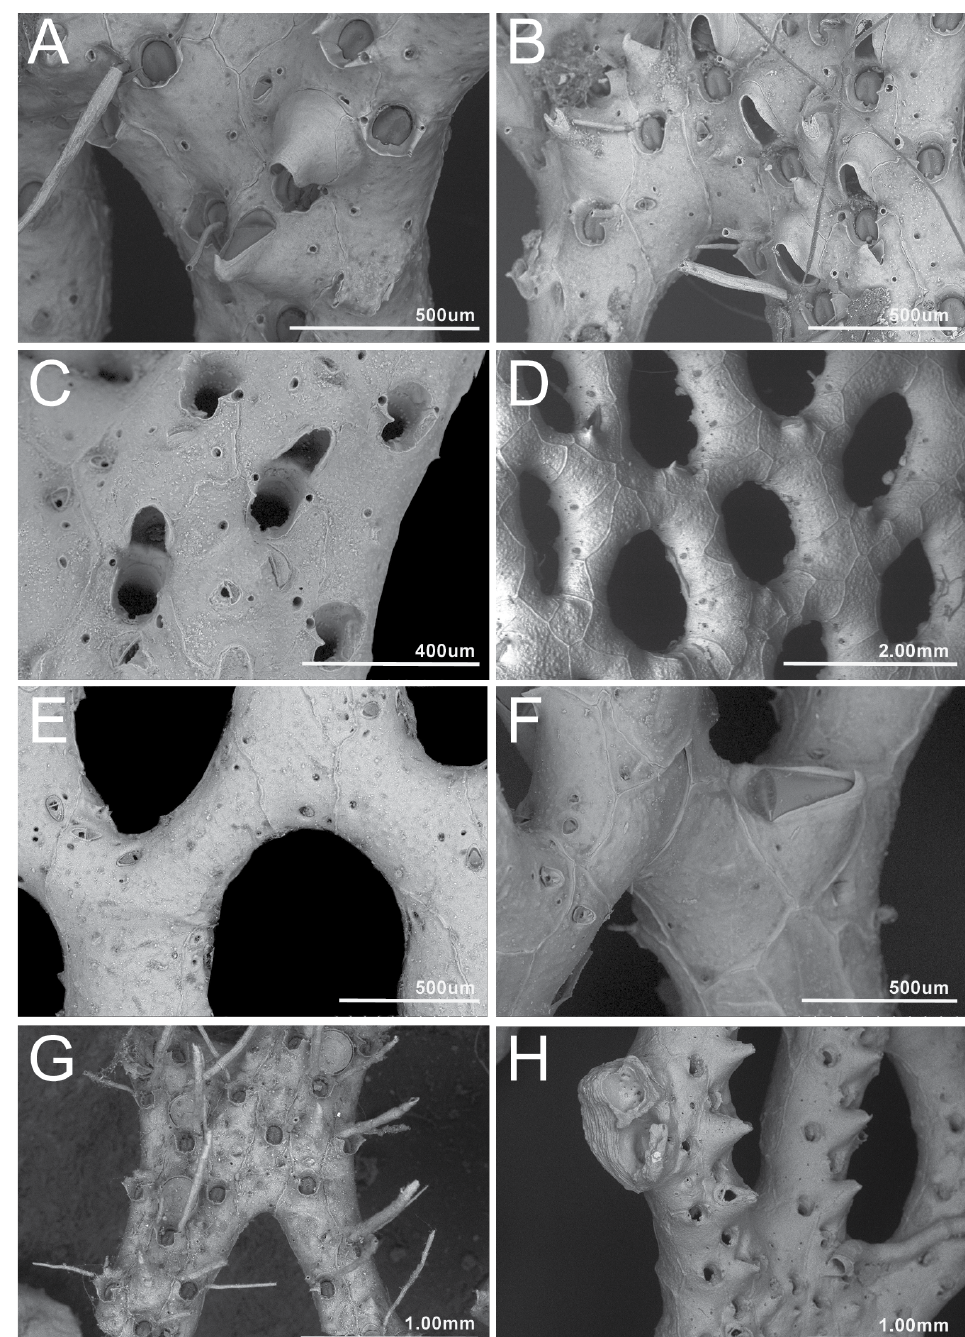
Fig. 10. Schizoretepora pungens (Canu & Bassler, 1925). A from Schizoretepora imperati , coll. Gautier (MNHN-IB-2008-11299); B, F from Schizoretepora pungens (MNHN-IB-2008-14434); C from Schizoretepora pungens , holotype, coll. Canu (MNHN-IB-2014-20); D from specimen labelled as Schizoretepora imperati (MNHN-IB-2008-9955); E, G from specimen labelled as Schizoretepora longisetae , coll. Canu (MNHN-IB-2014-19); H from Schizoretepora pungens (MNHN-IB-2008-14045). A–B . Two ovicell aspects in young colonies. C . Deeply immersed ovicells in older colonies. D . Abfrontal face showing rugose kenozooids separated by raised sutures. E . Abfrontal face showing two types of adventitious avicularia, both oval and almond-shaped. F . Abfrontal detail of giant avicularium at the basis of a fenestra and small oval avicularia. G . Aspect of spinose colony. H . Aspect of serrated